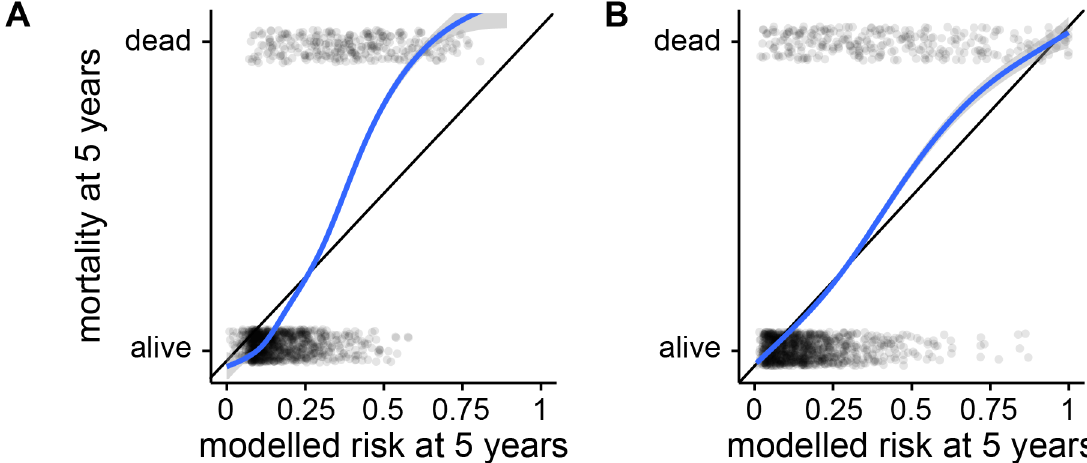
Fig 2. Example calibration curves for mortality at five years. Curves show calibration of (A) model 5 (poorly-calibrated) and (B) model 9 (well-calibrated) from Fig 1. Each semi-transparent dot represents a patient in a random sample of 2000 from the test set, the x -axis shows their risk of death at five years as predicted by the relevant model, and the y -axis shows whether each patient was in fact dead or alive at that time. The curves are smoothed calibration curves derived from these points, and the area between the calibration curve and the black line of perfect calibration is a in the calibration score, 1 − a